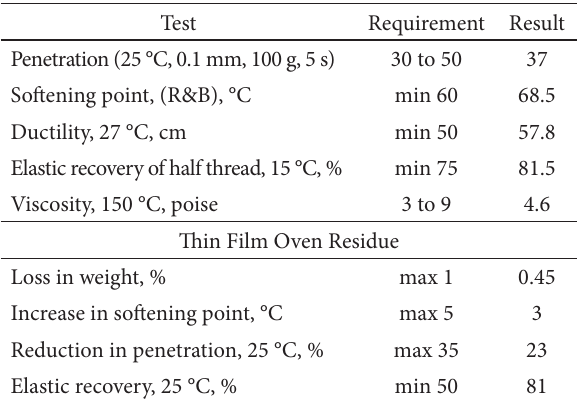
Fig. 1. Flowchart of experimental plan Table 2. Properties of PMB-40 bituminous